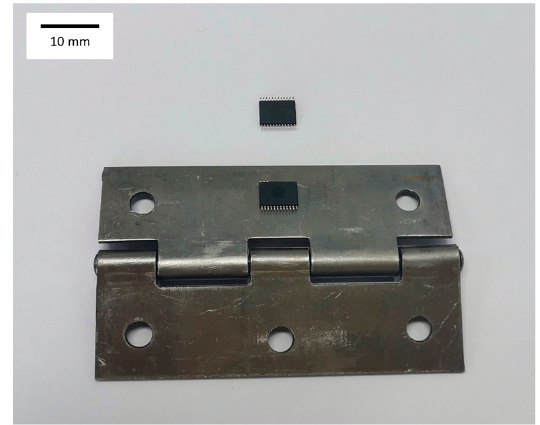
Figure 7. Two identical microchips.